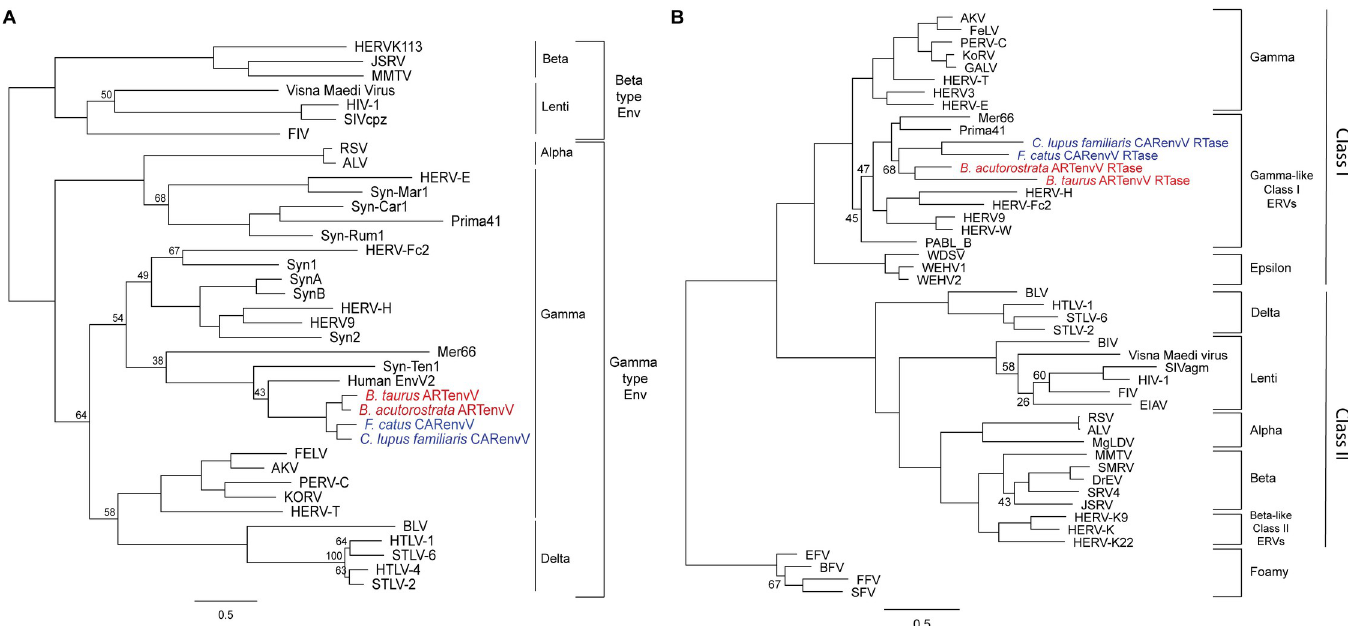
Fig 5. Phylogeny of CARenvV and ARTenvV proteins. A. The predicted amino acid sequence of CARenvV (in blue) and ARTenvV (in red) from the indicated species together with the amino acid sequence of selected endogenous and exogenous retroviral Env proteins (S2 Table) were aligned, and a maximum likelihood tree was generated using RaxML with 500 bootstraps. The tree was midrooted. B. Amino acid sequence of the predicted RTase domains of CARenvV ERV (in blue) and ARTenvV ERV (in red) from the indicated species together with the amino acid sequence of the RTase domain from the indicated endogenous and exogenous retroviruses (S2 Table) were aligned and a maximum likelihood tree was generated using RaxML with 500 bootstraps. The tree was rooted using foamy viruses. Bootstrap values that are less than 70 are shown at the relevant nodes. Scale bar represents 0.5 amino acid substitutions per